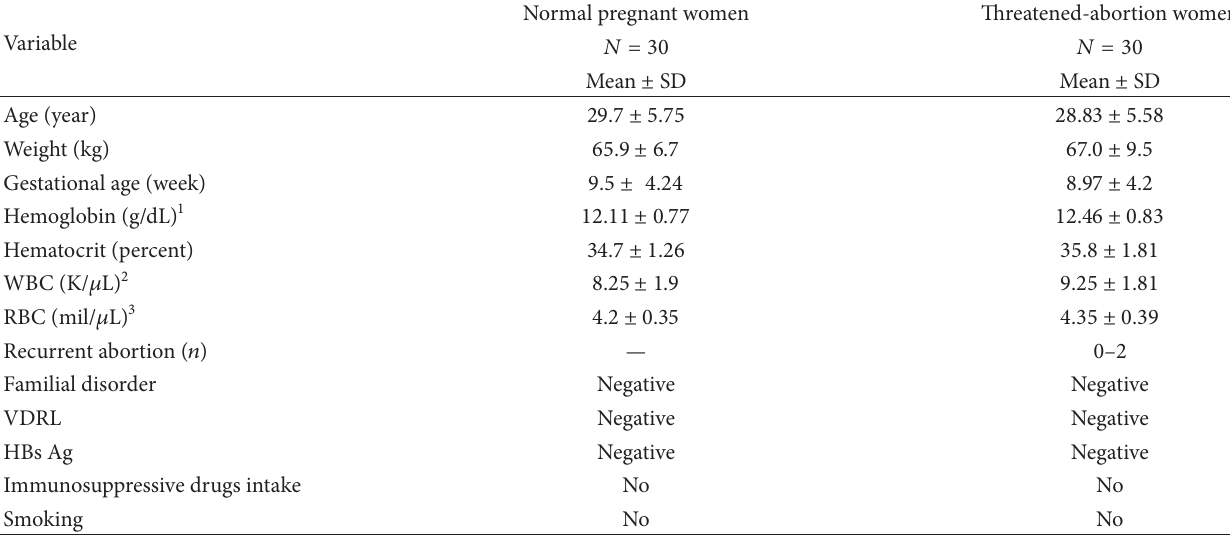
Table 1: Demographic characteristics and clinical parameters of threatened-abortion women and normal pregnant